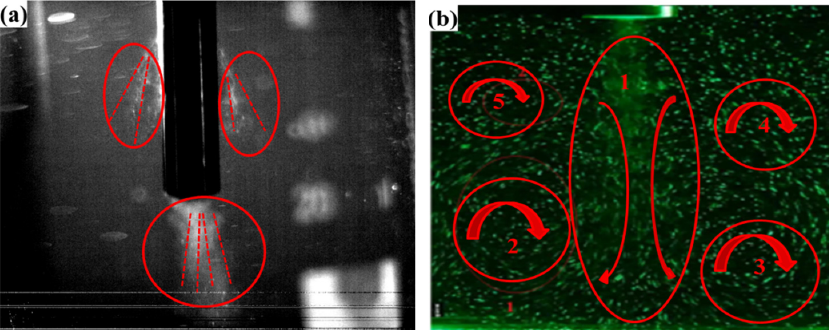
Figure 13. A high-speed image of ultrasonic leaching: ultrasonic cavitation ( a ); particle motion in the ultrasonic field ( b ).